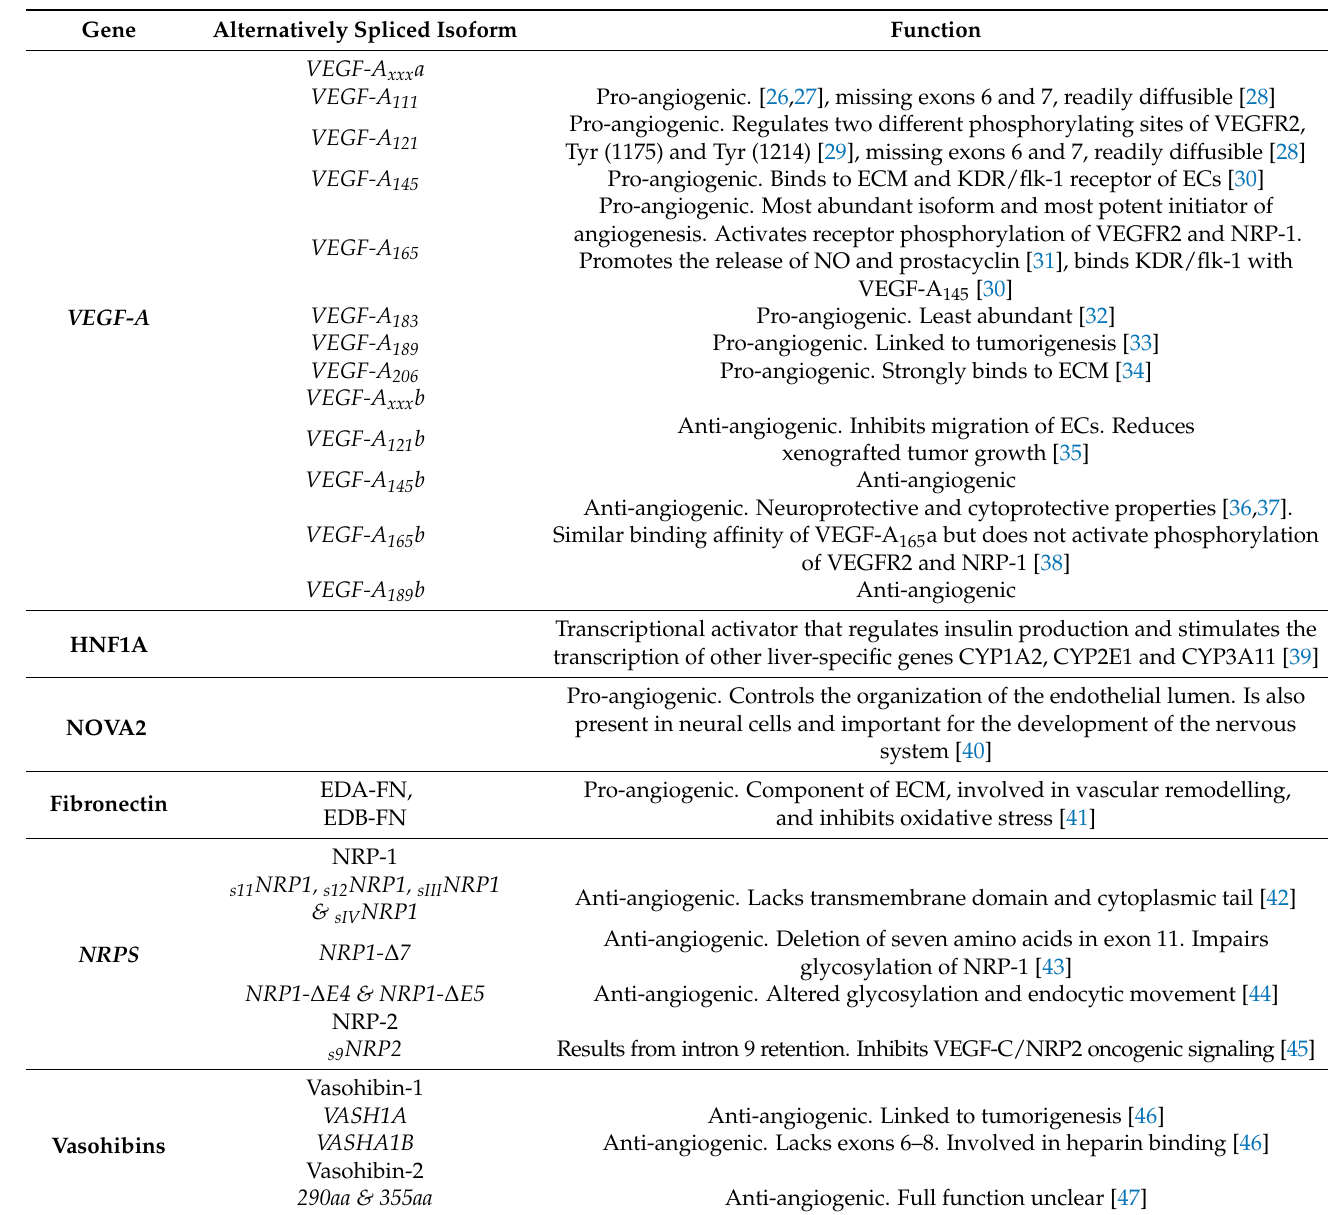
Table 1. A table displaying the effect of alternative splicing on vascular health and function through the generation of differing spliced isoforms. Abbreviations: ECs, endothelial cells; ECM, extracellular matrix; NO, nitric oxide.